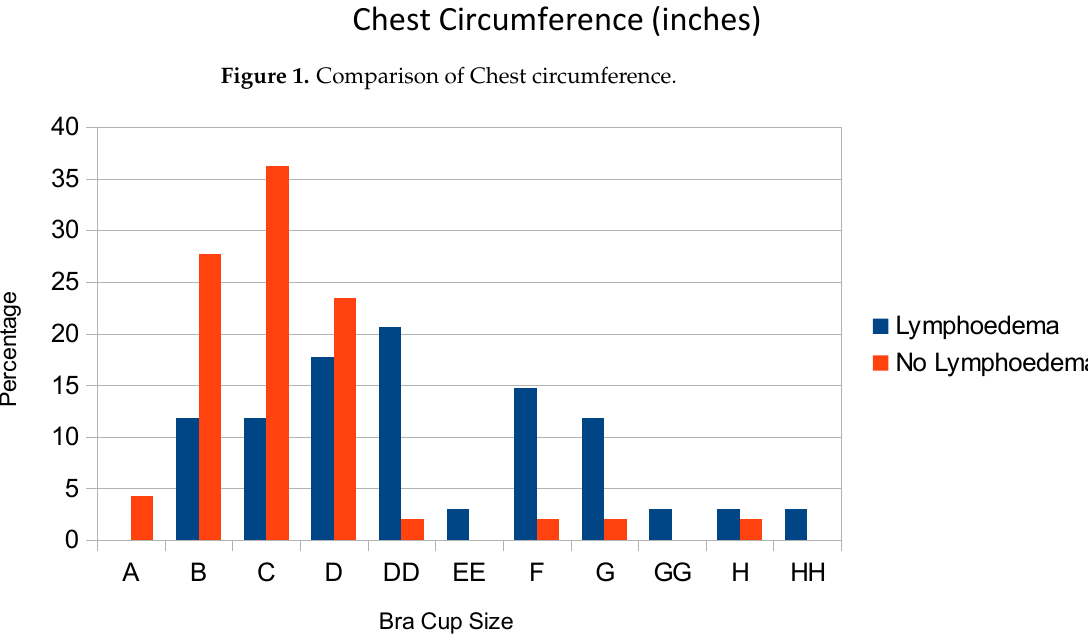
Figure 2. Comparison of Bra Cup Size.